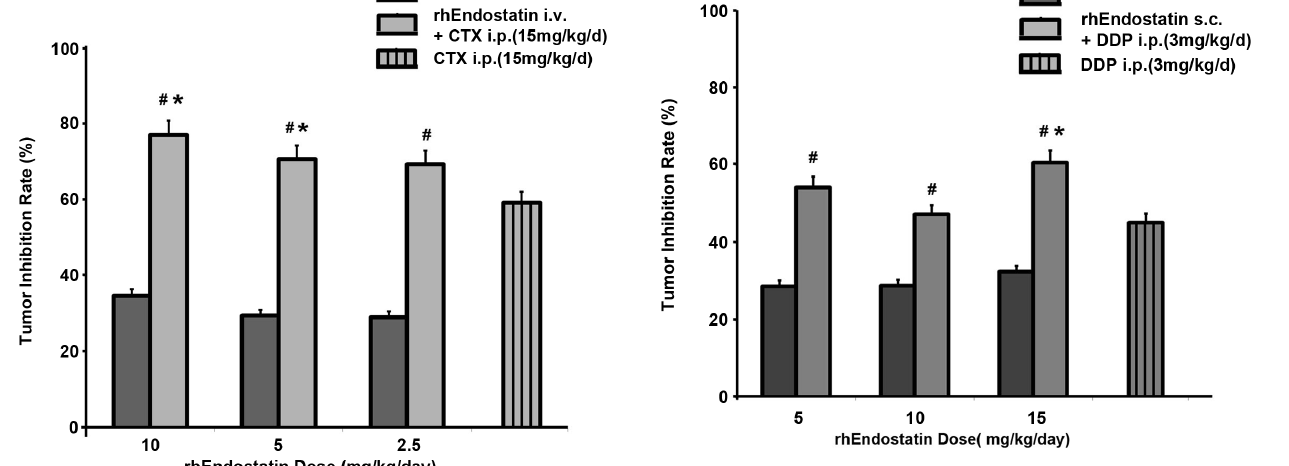
Figure 6. Additive effect of rhEndostatin with CTX on the metastasis of B16 melanoma. Nude mice (n=10, each) were inoculated with 2.5 6 10 5 tumor cells intravenously to establish a metastasis model. Mice were either administered i.v. with rhEndostatin alone at 10 mg/kg/day, 5 mg/kg/day, or 2.5 mg/kg/day for 15 days successively, or combined treated with CTX at the dosage of 15 mg/kg/ d for successively 7 days, then intravenously administered with rhEndostatin at 10 mg/kg/day, 5 mg/kg/day, or 2.5 mg/kg/day for successively 15 days. The mice were sacrificed to count the metastasis colony in the lung on day 25 post inoculation. The formula, [(mean colony of PBS control- mean colony of treated mice)/mean colony of PBS control] 6 100, was used to calculate the inhibition rate of metastasis. # : P , 0.05 vs mice administered with single rhEndostatin treatment at the same dose, respectively; *: P , 0.05 vs mice treated with CTX alone, at the dosage of 15 mg/kg/day.